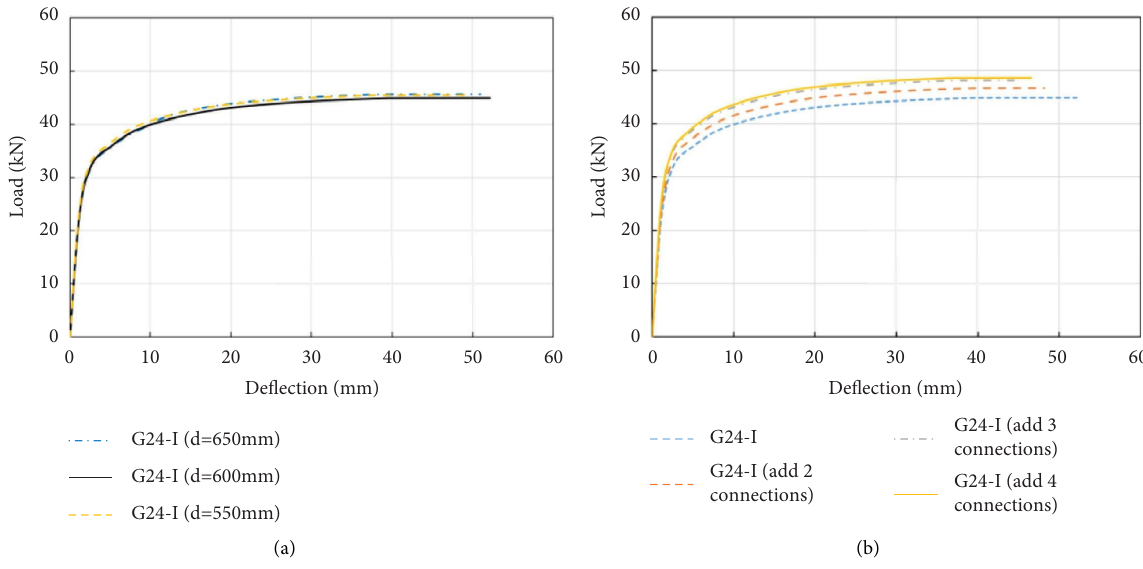
Figure 17: Simulated load-defection curves of G24-I (a) with diferent distances between the shear connectors and (b) with the diferent number of shear connectors. (a) Infuence of the distance between the connectors and (b) infuence of the number of shear connectors.